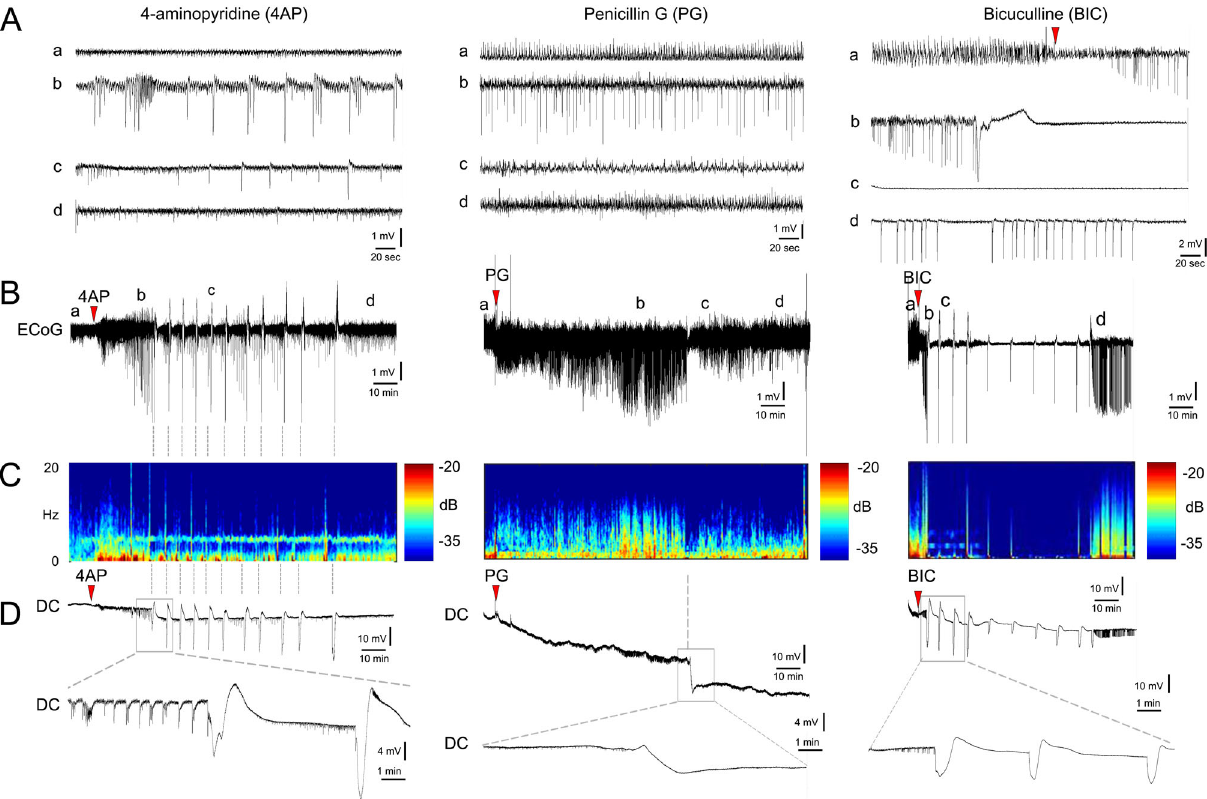
Fig. 2 Focal cortical seizures trigger spreading depression. A Representative tracings show typical ECoG phases (a – d) of 4AP, PG, or BIC microseizures, as indicated on the full ECoG timeline ( B ). Red arrowheads show the time of drug application. Vertical dashed lines indicate SDs. C Time – frequency-power spectra of the full timeline shown in B calculated using Thomson ’ s multitaper method. D Corresponding DC tracings show one or more SDs triggered during the seizures as large negative slow potential shifts. Boxes indicate expanded views. These were simultaneously con fi rmed on IOS as SD waves. A total of 11 spontaneous SDs originated from the 4AP window starting 23 min after drug application in this animal. PG seizure triggered 1 SD at 134 min and BIC seizure triggered 10 SDs between 3 and 60